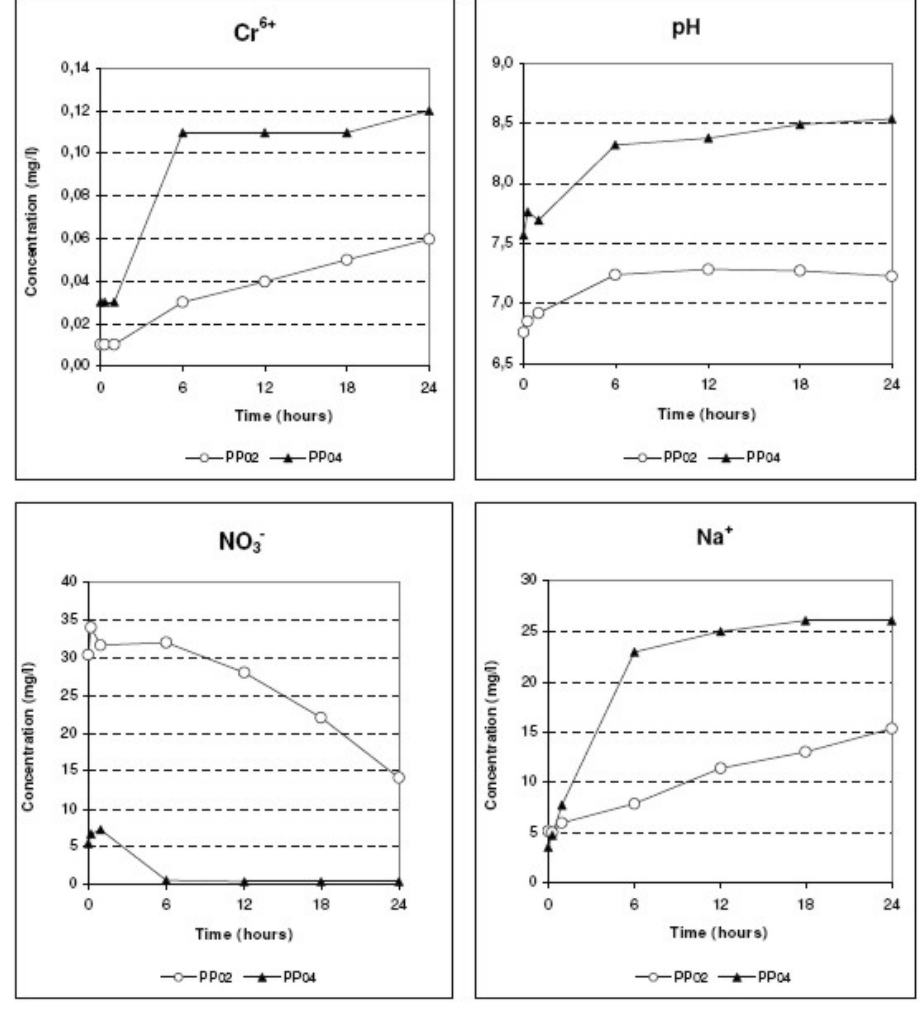
Fig. 6 – Variation of pH values and chromium, nitrate and sodium concentrations throughout pumping